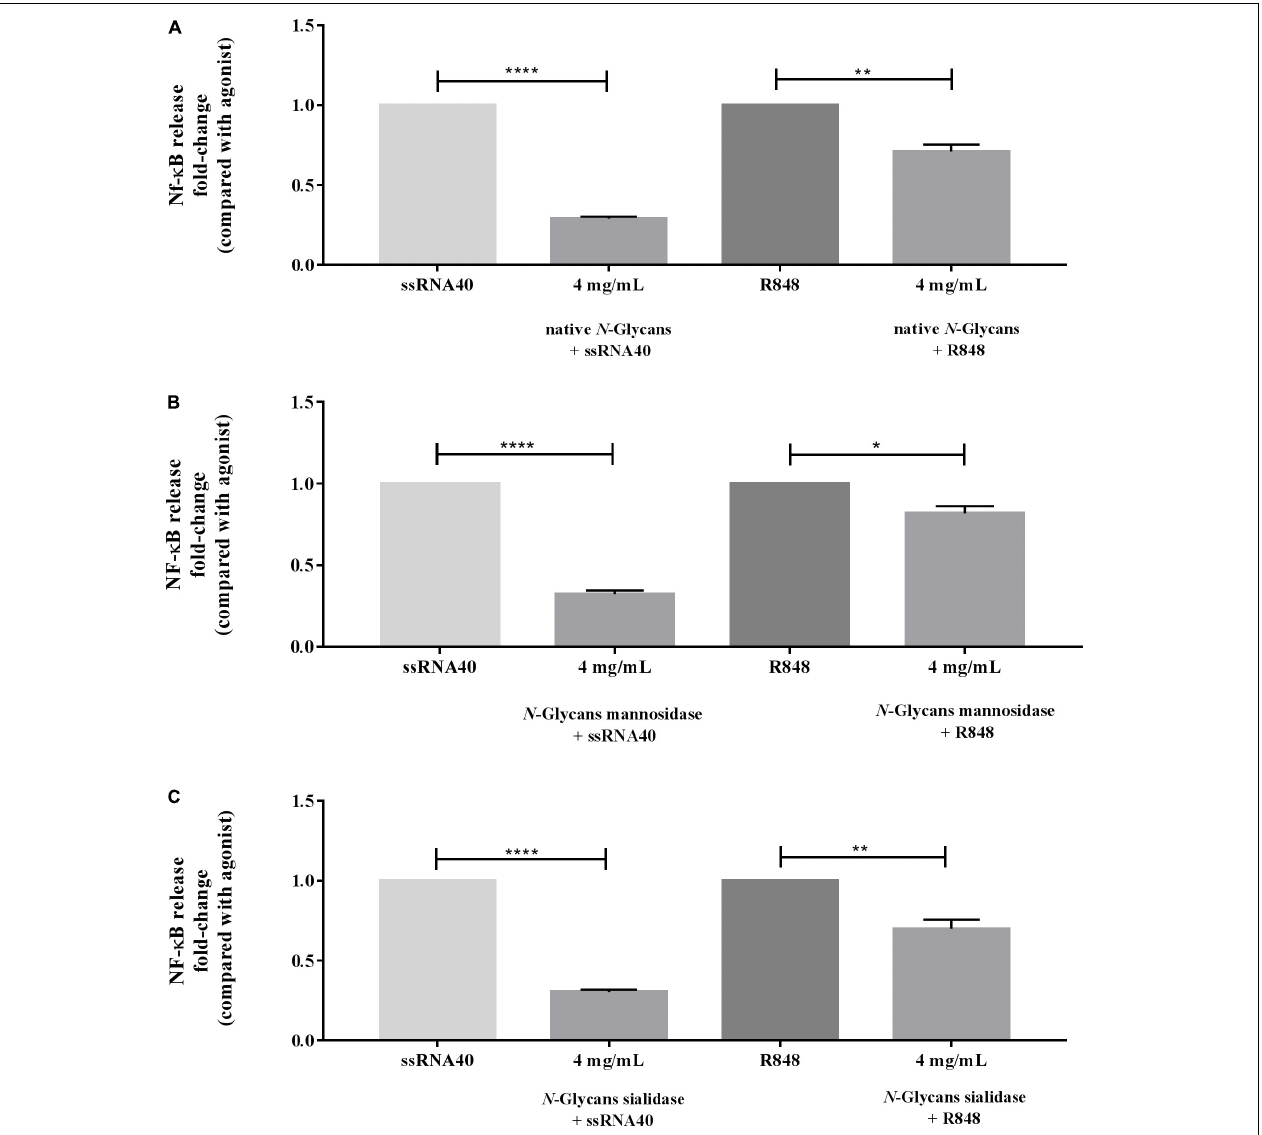
FIGURE 4 | Impact of the native, partially demannosylated and partially desialylated N -glycans on the inhibition of TLR-8 activation induced with ssRNA40 or R848. HEK293 cells expressing hTLR-8 were first incubated with (A) native N -glycans, (B) N -glycans treated with mannosidase, and (C) N -glycans treated with sialidase at 4 mg/mL ( n = 5). After 1 h, the TLR-8 agonists ssRNA40 (50 µ g/mL) and R848 (100 µ g/mL) were used to stimulate the cells. NF- κ B activation was measured by spectrophotometry at 650 nm. Data is represented as mean ± SEM. Statistical differences were measured using paired t -test. Significant differences compared to ssRNA40 and R848 are indicated by * p < 0.05, ** p < 0.01, and **** p <